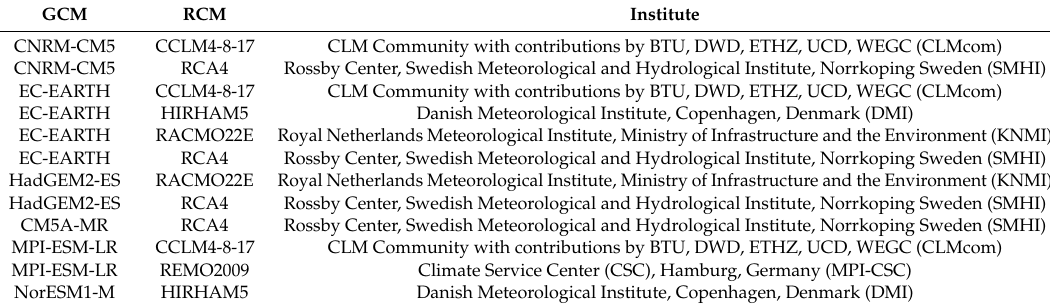
Table 3. Combinations of numerical models applied in